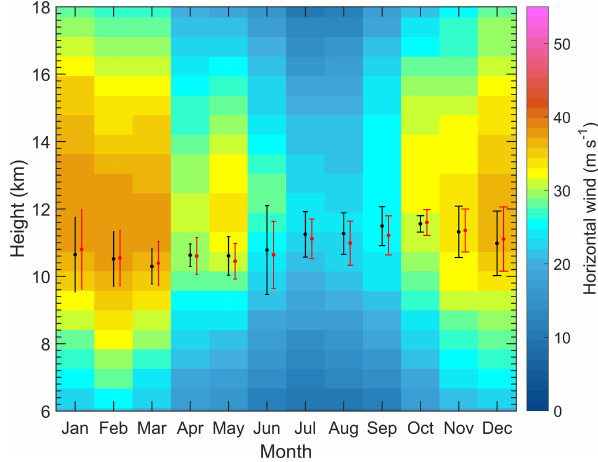
Figure 9. Height–time intensity map of monthly mean horizontal wind speed (shaded; ms − 1 ) derived from the middle mode of Bei- jing MST radar during November 2011–May 2017. Also shown is the monthly mean height of RT (black dots) and LRT (red dots; offset by + 6d) along with the vertical error bars representing the standard